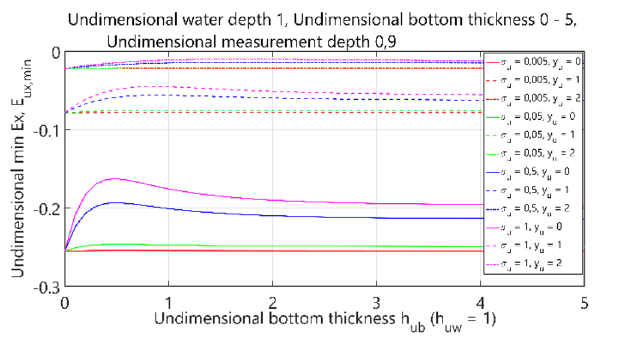
Figure 37. Dependence of E ux,min on h ub